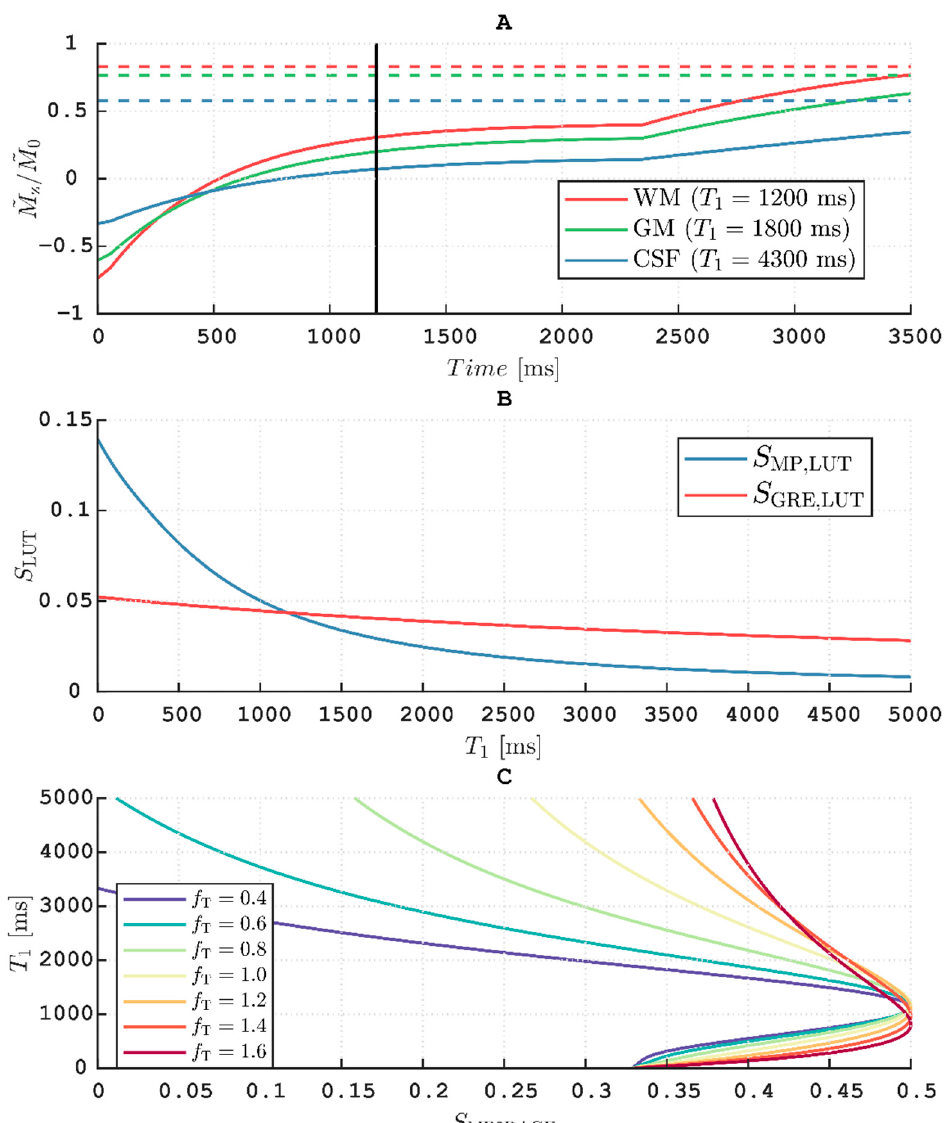
Figure 7. ( A ) Solid coloured lines show the evolution of M z during an MPRAGE acquisition across T cycle = 3500 ms and f T = 1 for three values of T 1 exemplifying WM, GM, and CSF. The dashed lines show the corresponding steady-state of the reference GRE. Vertical black line denotes the center of k-space at TI = 1200 ms. ( B ) The two LUT signals as a function of T 1 for f T = 1. ( C ) Estimated T 1 as a function of S MP2RAGE for different f T . Areas with longer T 1 were disproportionately biased by deviations in f T . Depending on f T , the minimum T 1 that could be uniquely defined ranged from 1181 ms ( f T = 0.8) and 810 ms ( f T = 1.6). At f T = 0.4, there was also an upper limit at 3330 ms.